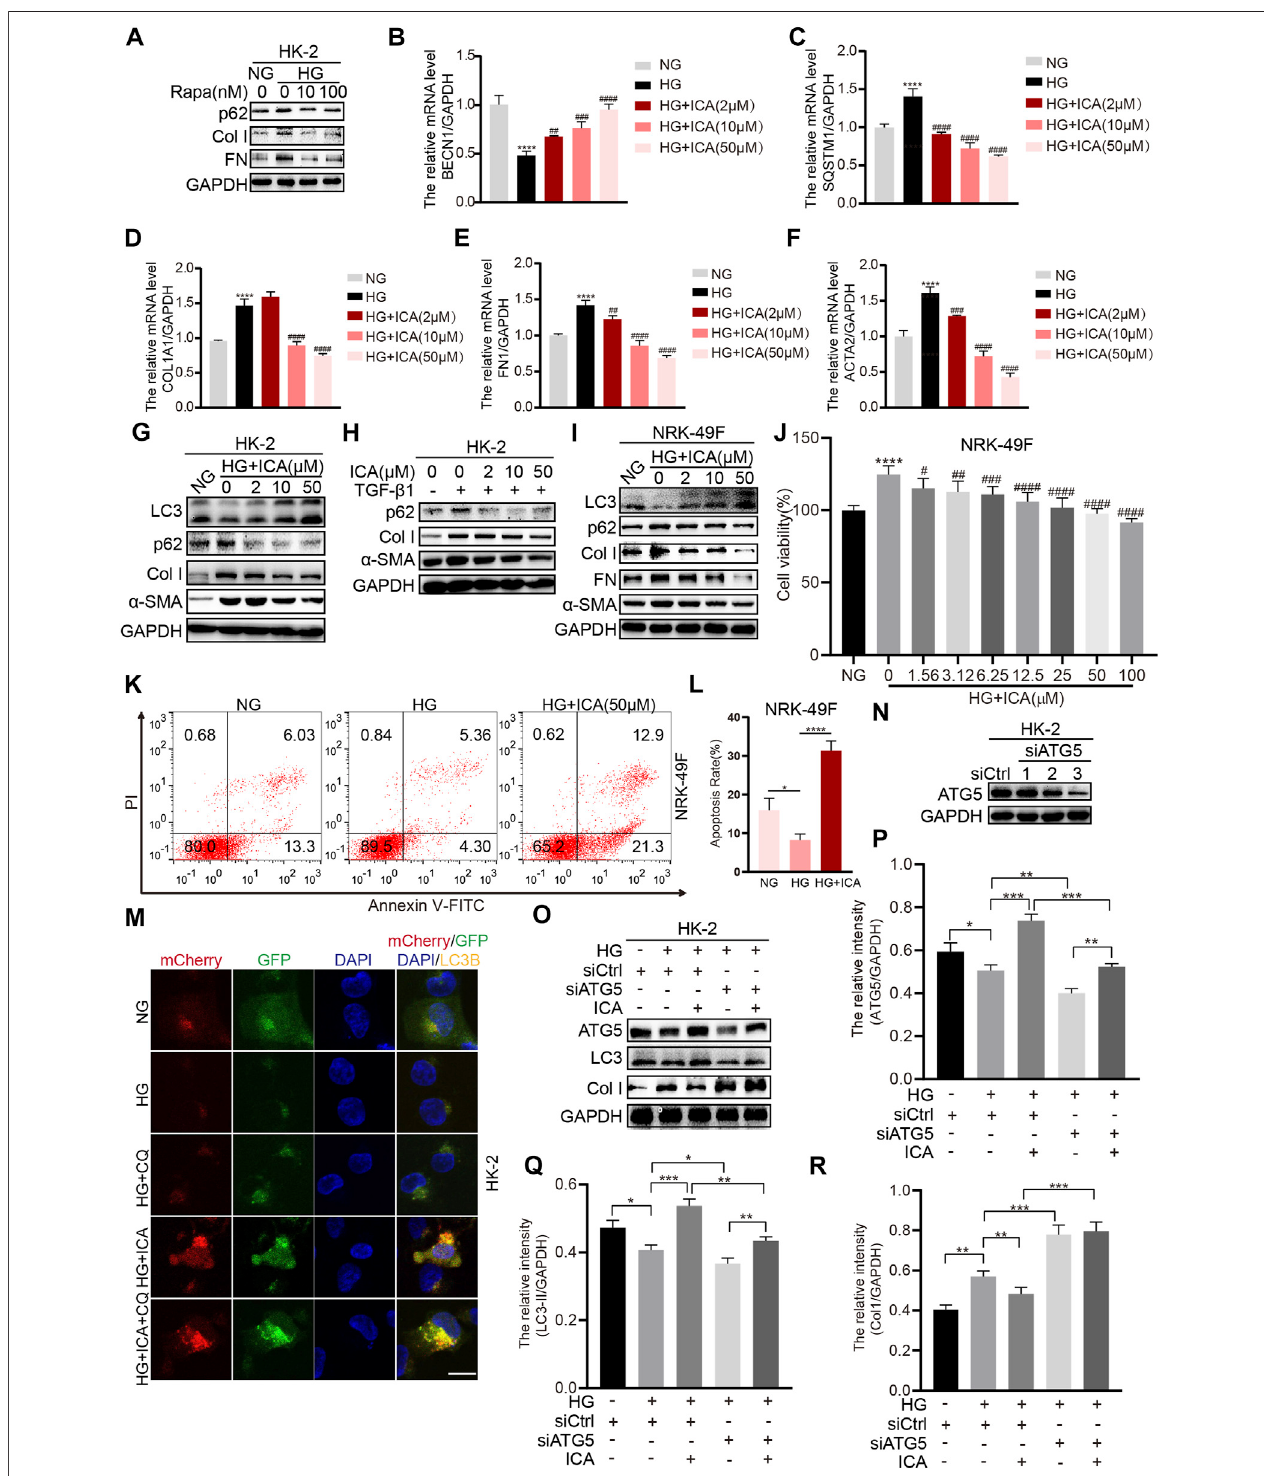
FIGURE 3 | ICA alleviates fi brosis by inducing autophagy in HK-2 and NKR-49F cells (A) HK-2 cells were treated with HG and rapamycin for 48 h, then the expression of p62, Col I, and FN was determined by Western blot (B – F) The relative levels of BECN1 , SQSTM1 , COL1A1 , ACTA2 , and FN1 were detected by real-time PCR after HK-2 cells were stimulated with HG and various concentrations of ICA for 48 h **** p < 0.0001 vs NG; ## p < 0.01, ### p < 0.001, #### p < 0.0001 vs HG (G – I) Protein expression of autophagy and fi brosis in HK-2 and NRK-49F cells after incubation with HG and ICA (2, 10, 50 μ M) or TGF- β 1 (5 ng/ml) for 48 h (J) The cell